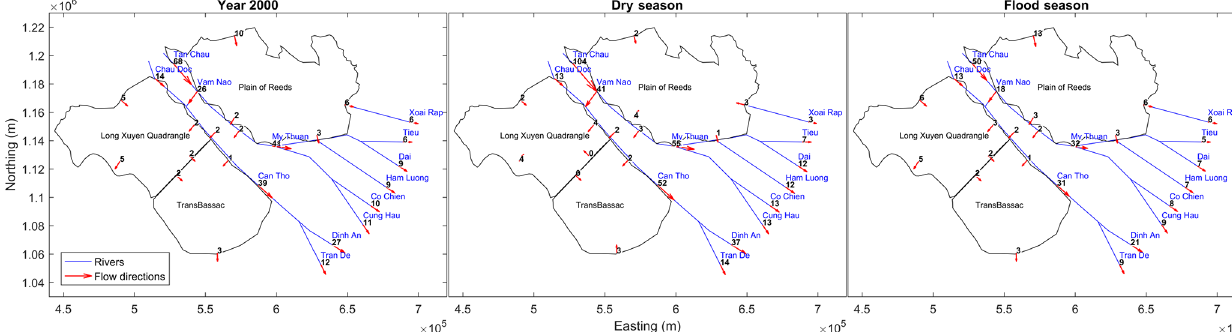
Figure 8. Percentages (compared with the total water volume at Kratie) of water distribution throughout the VMD in 2000.